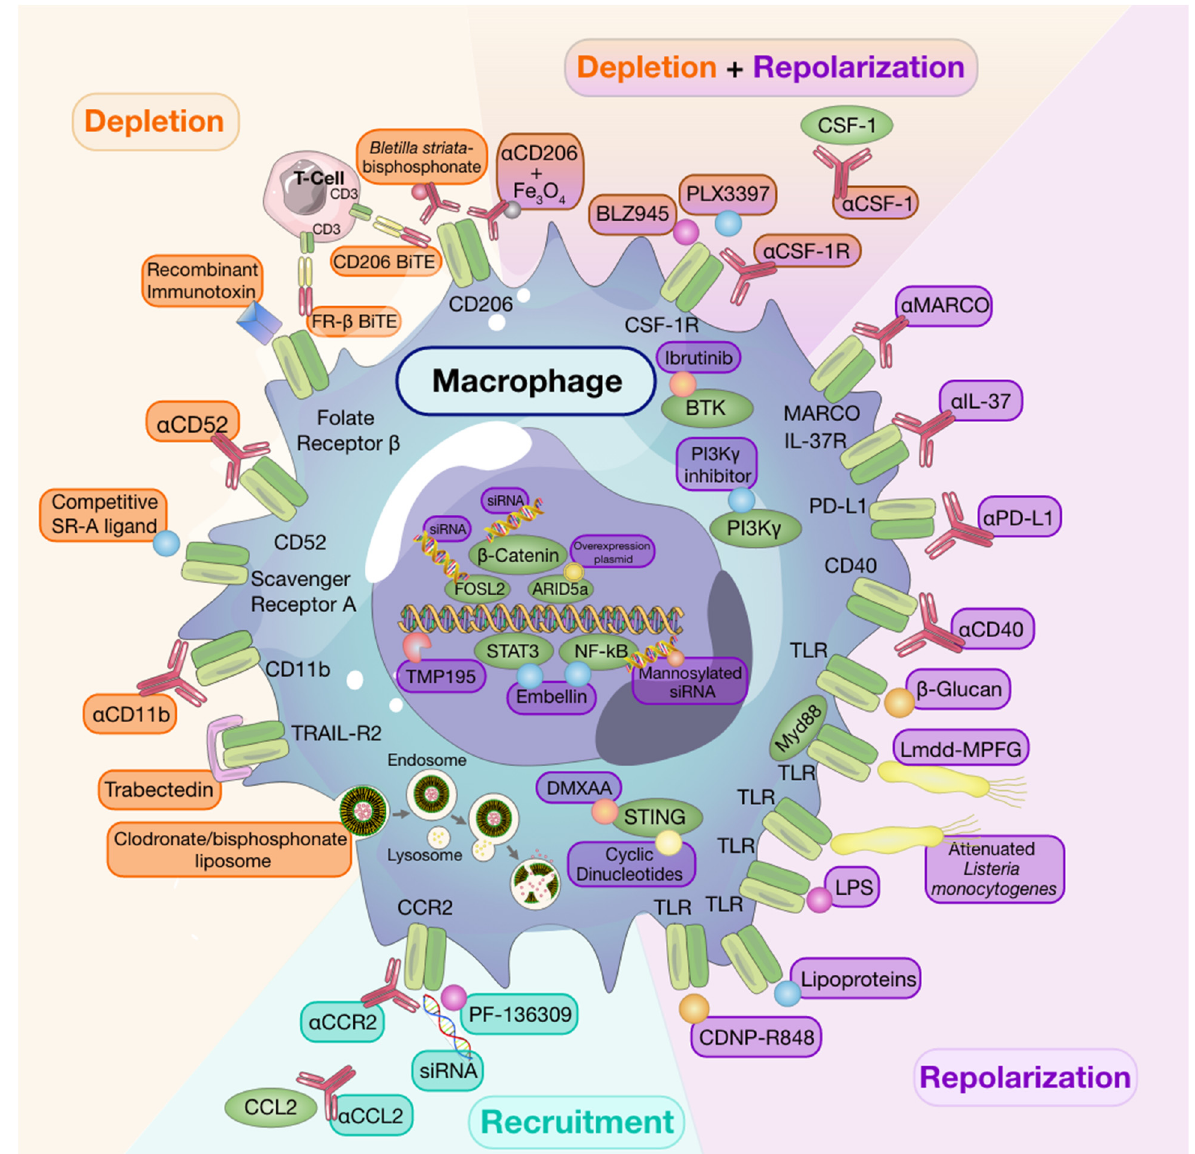
Figure 1. Therapeutic strategies targeting macrophages and their tumor-promoting phenotypes . Macrophage depletion, inhibiting macrophage recruitment, and/or promoting repolarization of macrophages towards anti-tumor phenotypes